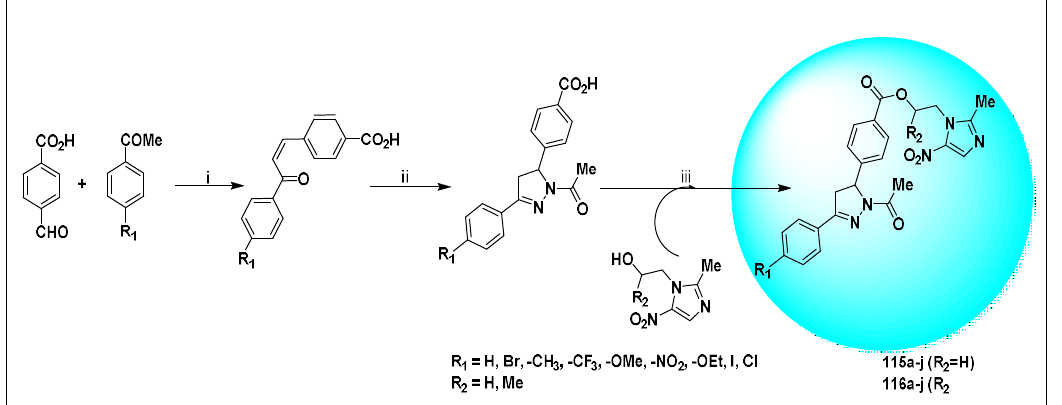
Scheme 57. Synthesis of pyrazolylnitroimidazole derivatives as anticancer agents. Reagents